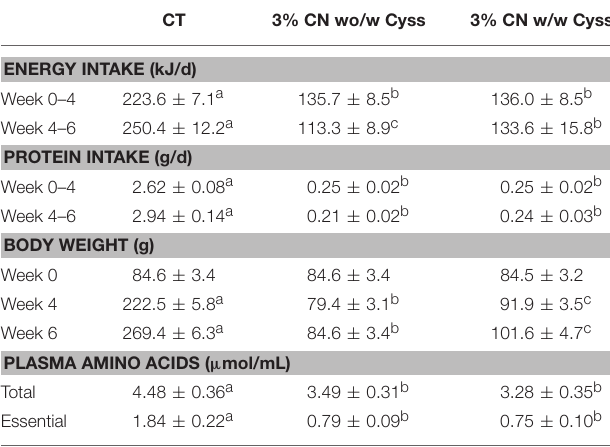
Data are expressed as means ± SD (n = 6), and values with different superscript letters aresignificantlydifferent(P < 0.05).CN,CT,andCyssdenotecasein,control,andcystine,